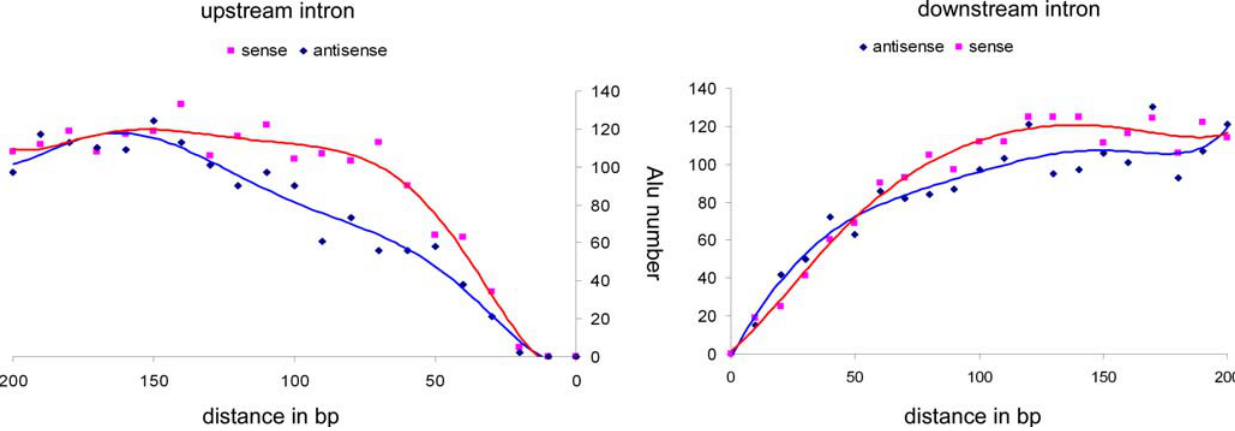
Figure 1. Bioinformatic analysis of Alu insertion within the flanking introns. Conserved constitutively spliced exons were analyzed for the differences in the location of antisense and sense Alu s within the upstream and downstream introns (left and right panels, respectively). The x-axis is the distance in base pairs from the exon; the y-axis is the number of Alu s found within this distance. Antisense Alu s are marked in blue and sense Alu s are marked in